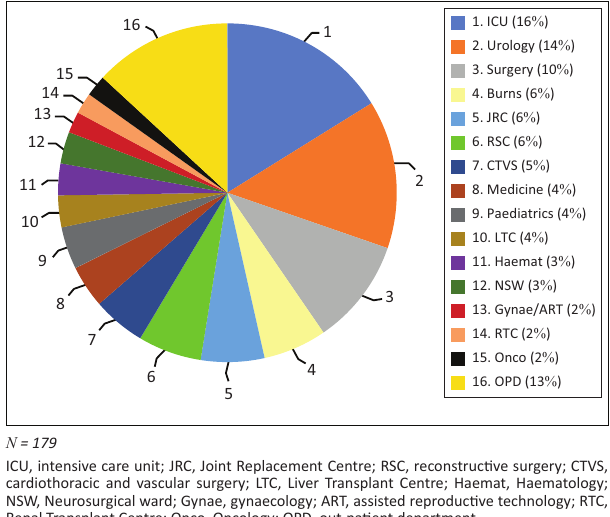
NSW, Neurosurgical ward; Gynae, gynaecology; ART, assisted reproductive technology; RTC, Renal Transplant Centre; Onco, Oncology; OPD, out-patient department. FIGURE 2: Ward distribution of samples included in the study at a hospital in Delhi, India, February 2017 to June